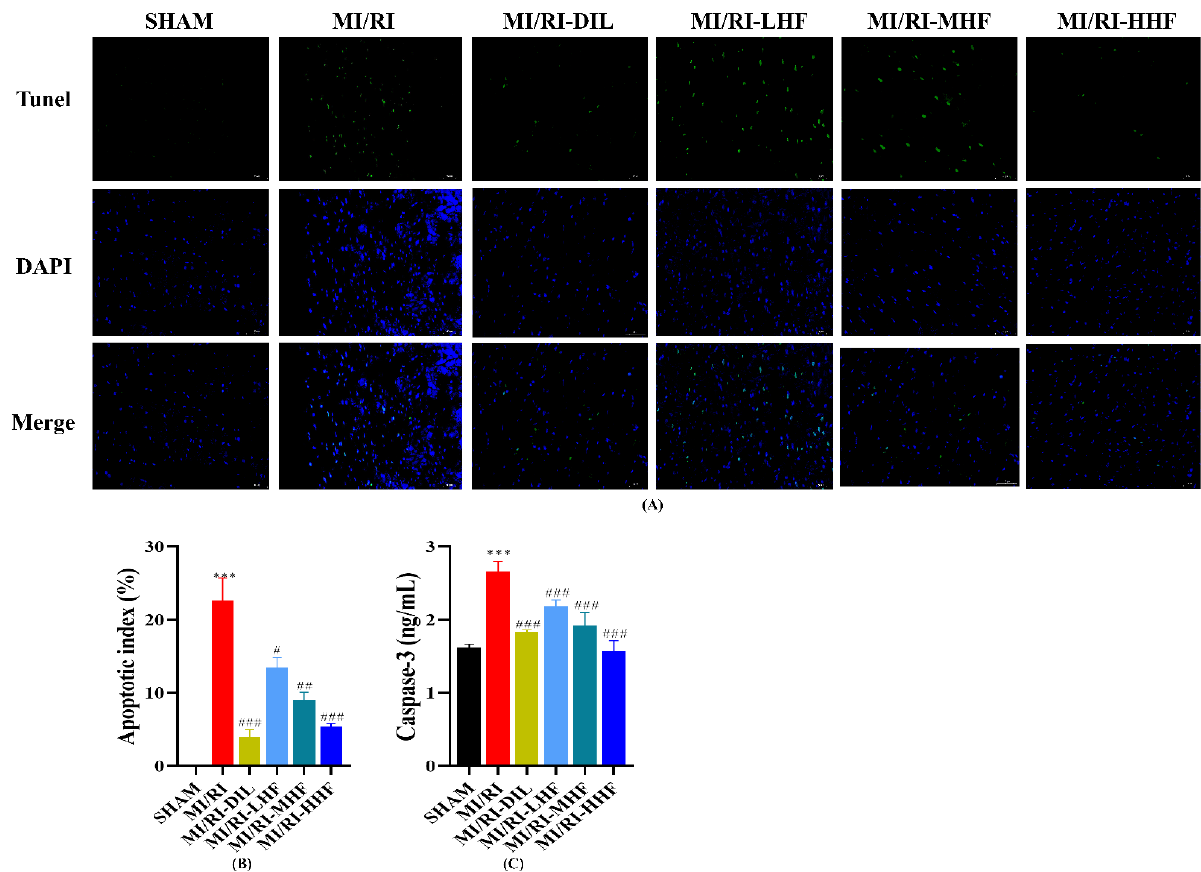
Figure 7. Effect of HF on TUNEL positivity and apoptotic markers. ( A ) The results of the TUNEL assay (400×). ( B ) Apoptotic index. ( C ) The serum of caspase-3. *** p < 0.001 vs. SHAM group. # p < 0.05, ## p < 0.01, ### p < 0.001 vs. MI/RI group.